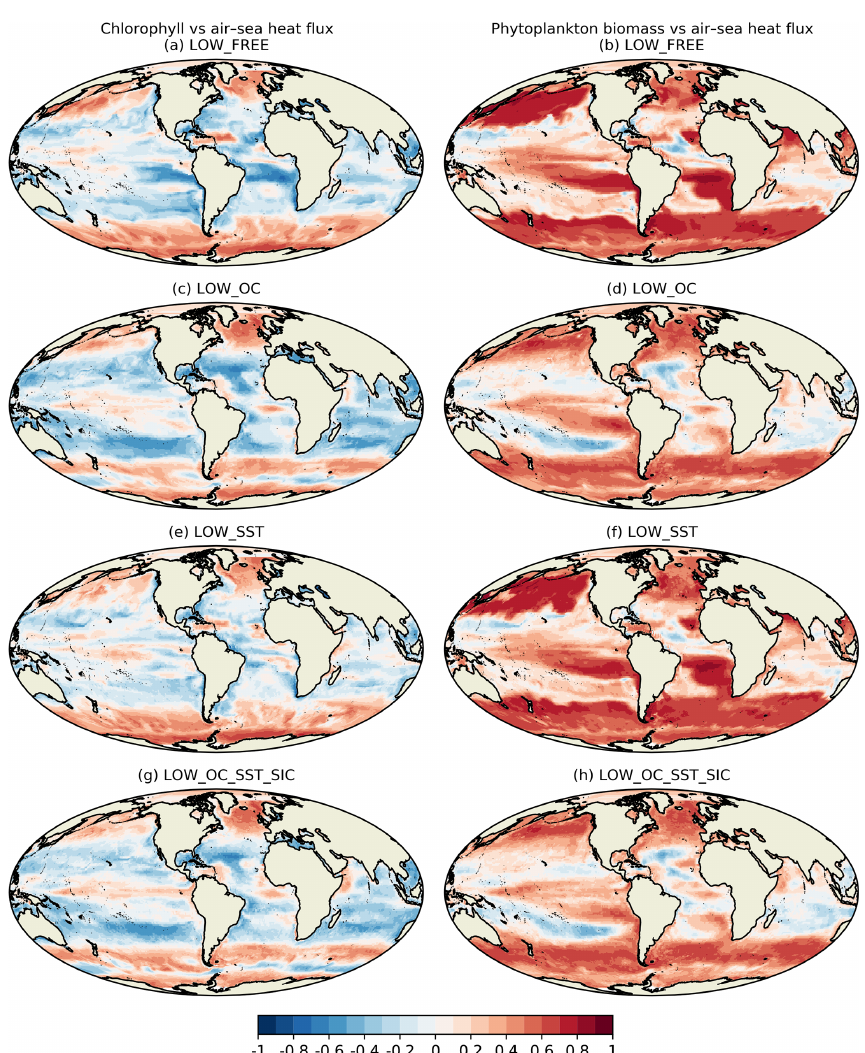
Figure 9. Maps of correlation between surface chlorophyll and net air–sea heat flux (left column) and between surface phytoplankton biomass and net air–sea heat flux (right column), covering 1998–2010 for a selection of